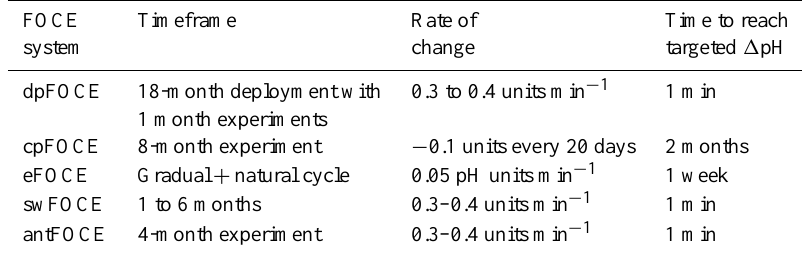
Table 3. Initial change in pH performed (or planned) during the different FOCE experiments.